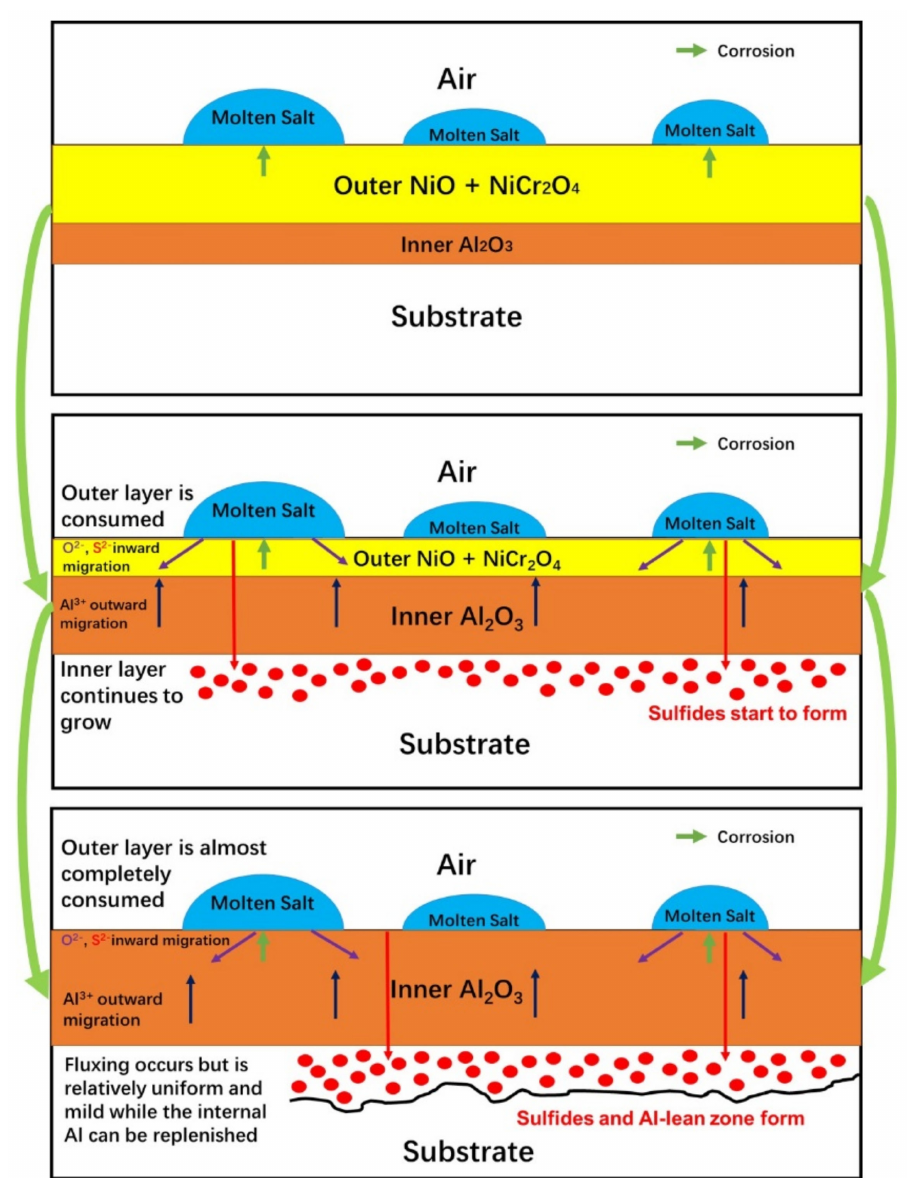
Figure 9. The schematic diagram of the oxides’ changes in hot corrosion after